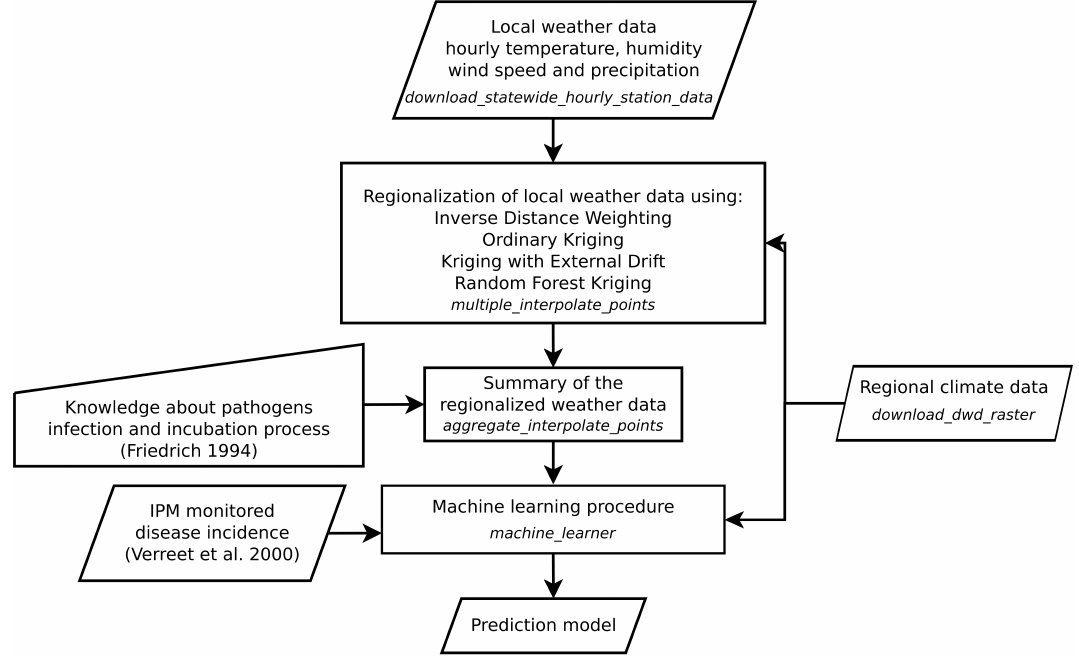
Figure 2. The proposed modelling approach combining machine learning and spatial interpolation methods (including the functions of the package papros